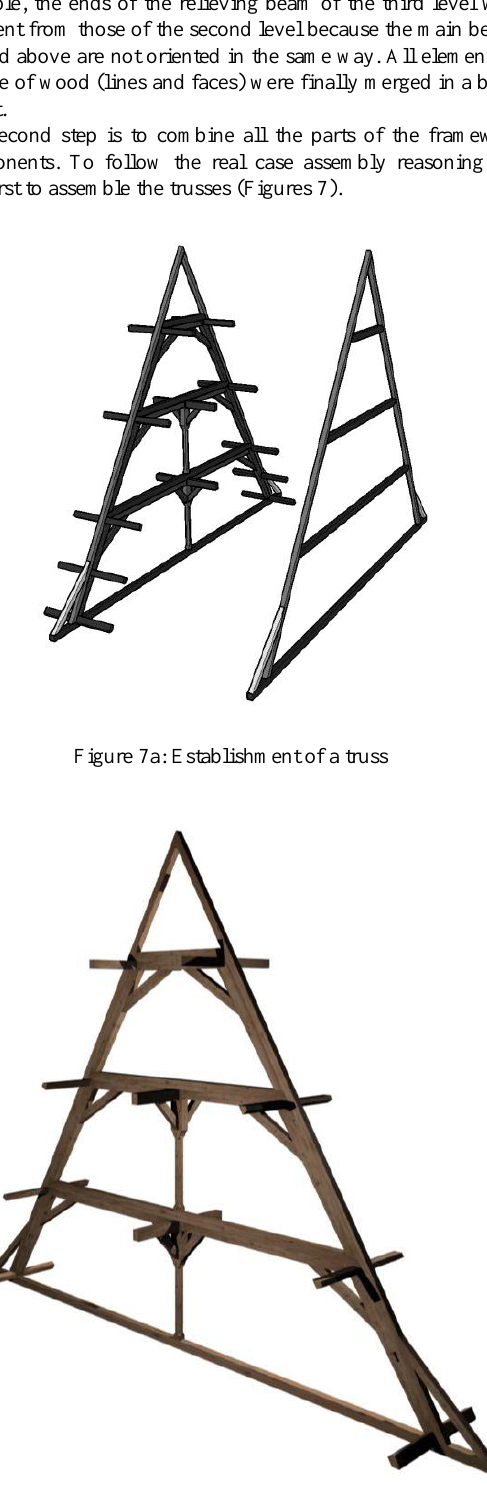
Figure 7b: Model of textured